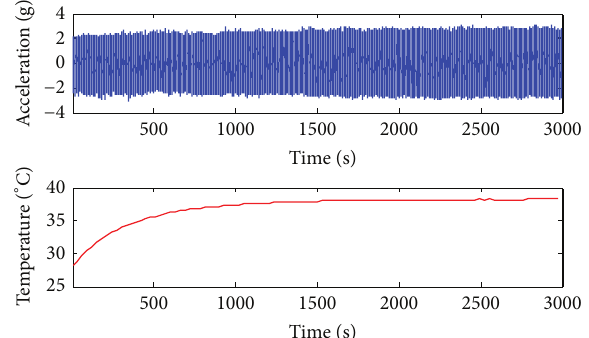
Figure 6: Evolution of the acceleration signal versus the motor temperature.